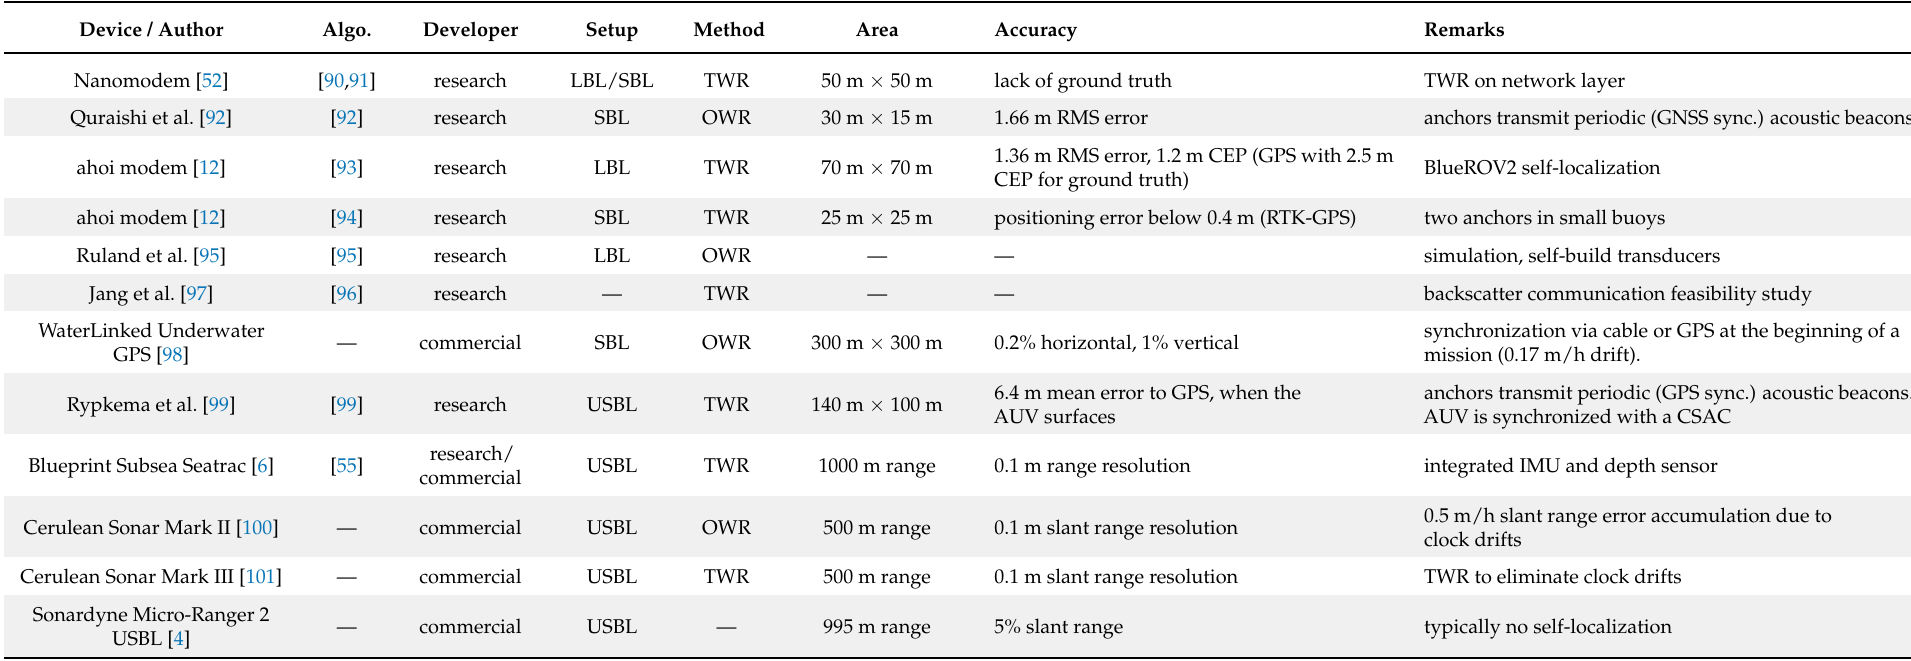
Table 3. Comparison of different low-cost acoustic positioning systems. Abbreviations: one way ranging (OWR), two way ranging (TWR), long baseline (LBL),